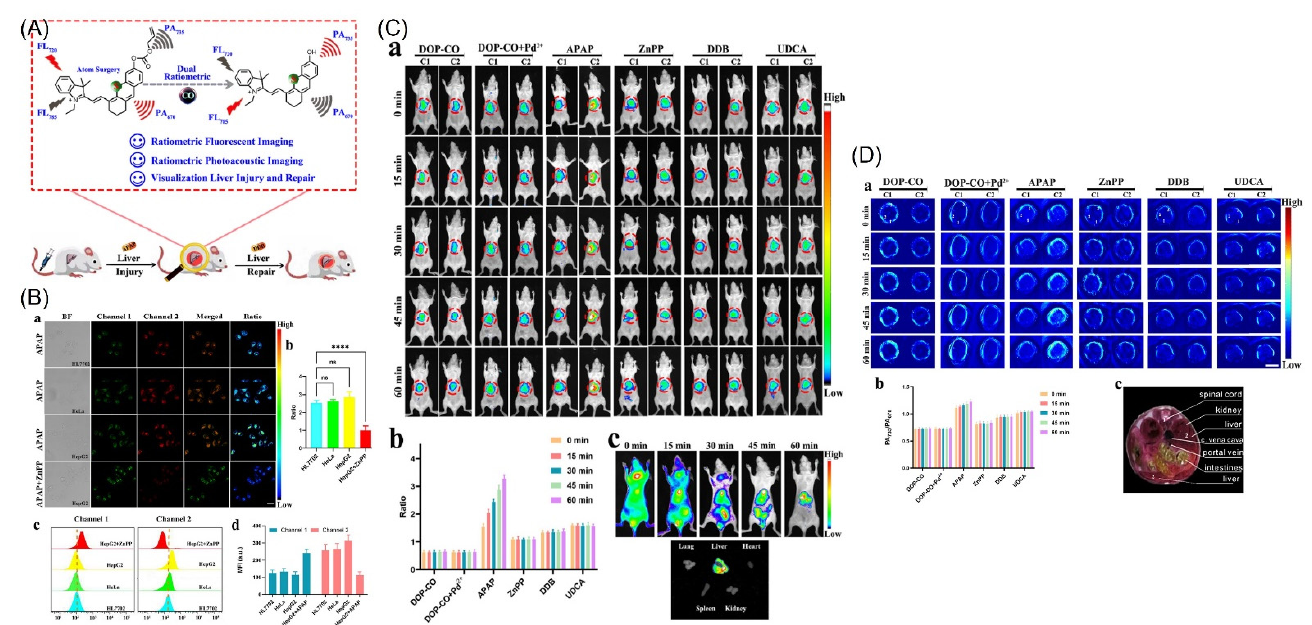
Figure 11. ( A ) A scheme of the FL/PA dual-mode probe 27. ( B , C ) APAP-induced endogenous CO fluorescence imaging in different cells and living mice. ( D ) PA images of living mice. Copyright (2022) Elsevier Ltd. [42]. **** p < 0.0001.